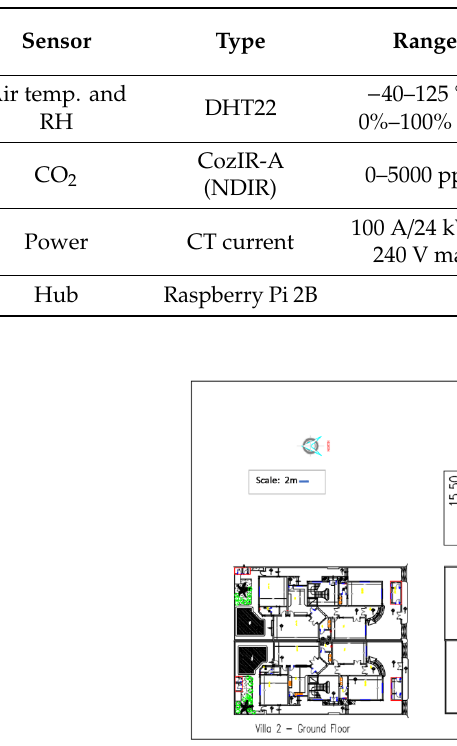
Table 1. The specifications of the sensors used in this study.